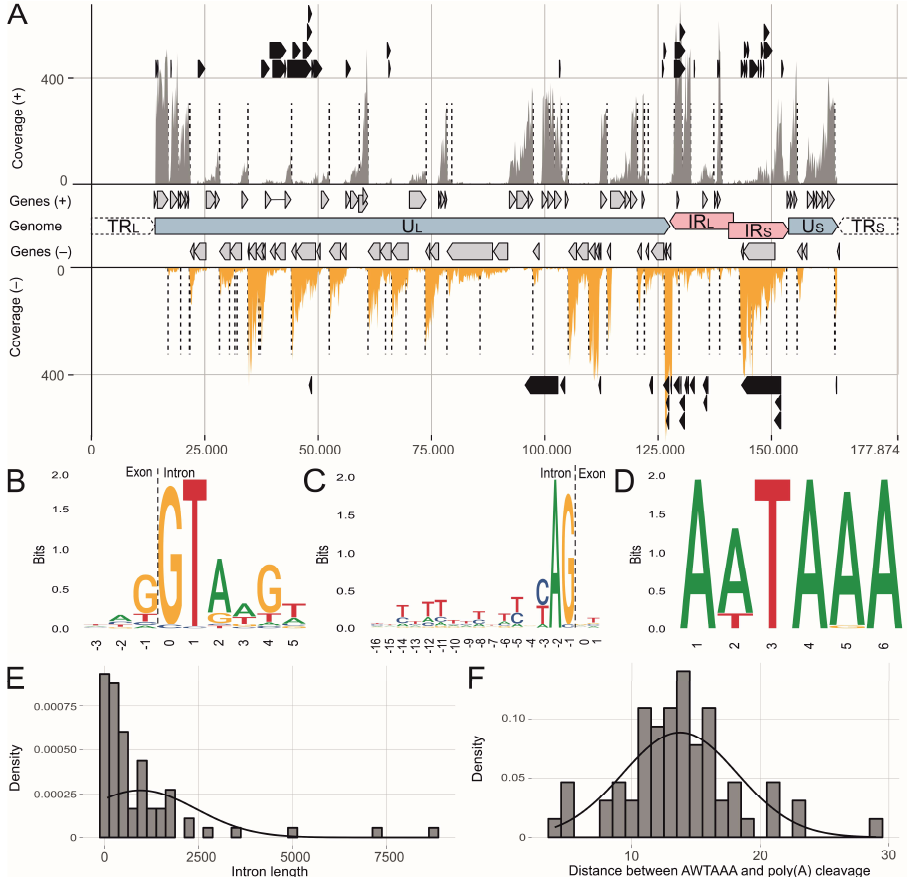
Figure 2. Overview of Marek’s disease virus (MDV) mRNA splicing and poly(A) cleavage. ( A ) Visualization of the cumulative CVI988 and RB1B RNA-seq coverage of plus (+) and minus (-) strand-encoded genes across the MDV genome. Black arrow bars indicate introns and dashed lines indicate poly(A) cleavage sites. More detailed information is shown in Table S4 and Table S5. ( B ) Nucleotide frequency maps (sequence logo) of splice donor sites in MDV-encoded mRNAs. The relative heights of letters correspond to frequencies of bases at each position. ( C ) Sequence logo of splice acceptor sites in MDV-encoded mRNAs. ( D ) Sequence logo of polyadenylation signals in MDV-encoded three prime untranslated regions (3′-UTR). ( E ) Histogram depicting MDV intron length distributions. ( F ) Histogram depicting the distance from AWTAAA-like motifs to the poly(A) cleavage site.